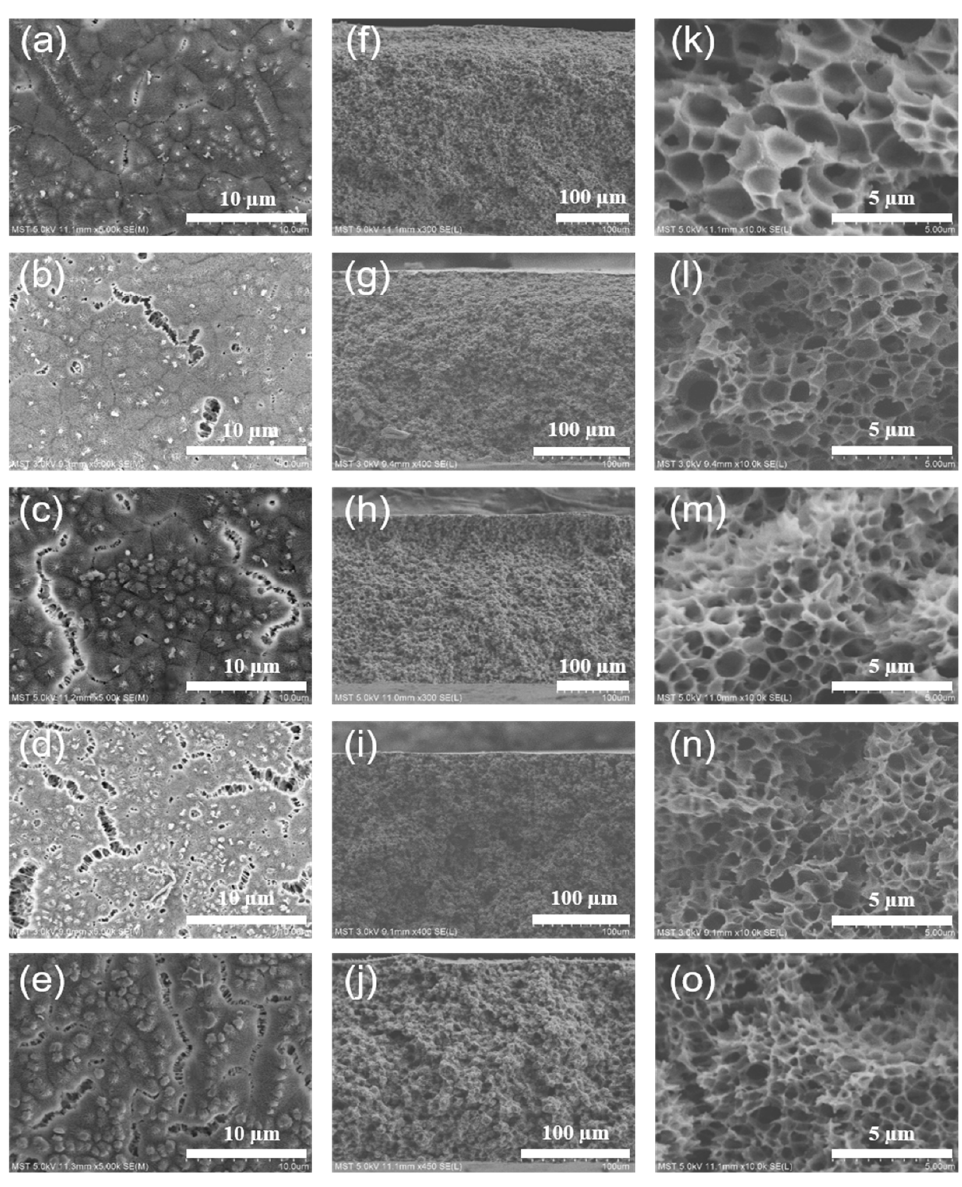
Figure 6. Surface SEM images of ECTFE membranes prepared with different TOTM contents: ( a ) 10%; ( b ) 13%; ( c ) 15%; ( d ) 17%; ( e ) 20%. Cross section SEM images of ECTFE membranes prepared with different TOTM content: ( f ), ( k ) 10%; (g), ( l ) 13%; ( h ), ( m ) 15%; ( i ), (n) 17%; ( j ), ( o ) 20%.